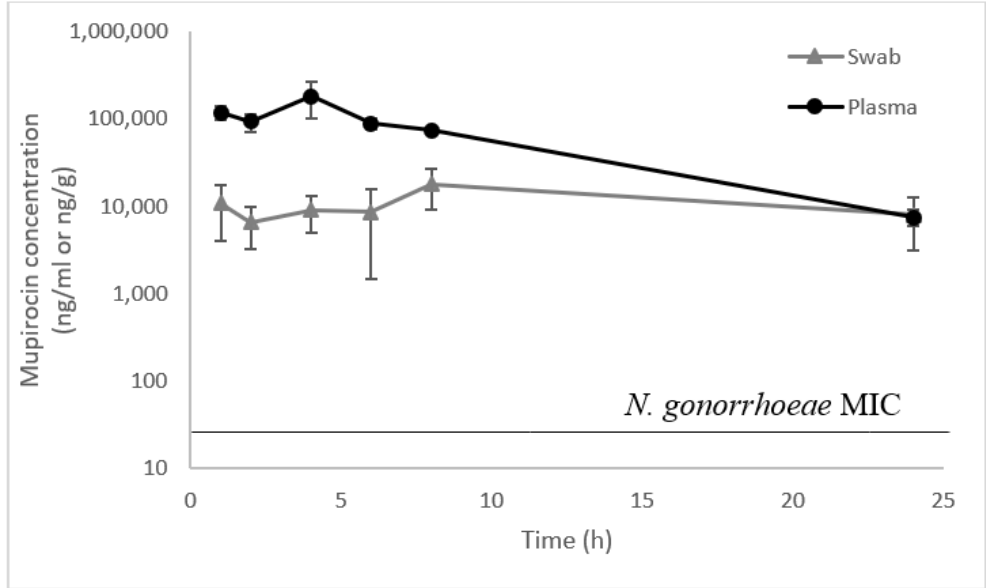
Figure 4. Mupirocin concentration (free (non-liposomal) plus liposomal) in vaginal secretions (ng/g) and plasma (ng/mL) following IP administration of Nano-mupirocin 50 mg/kg (mean ± SE). ( n = 5 for swab samples and n = 4 for plasma samples).